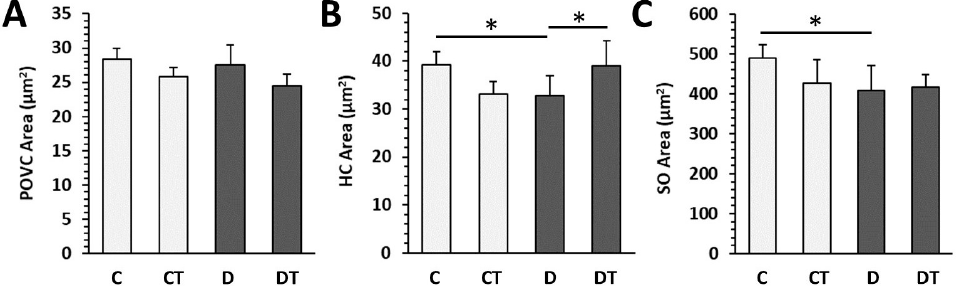
Figure 6. Histomorphometrical parameters in non-diabetic rats (C), those treated with cemtirestat (CT), STZ-induced diabetic rats (D), and those treated with cemtirestat (DT). ( A ) Primary osteons’ vascular canals (POVC) area, ( B ) Haversian canals (HC) area, and ( C ) secondary osteons (SO) area. The values are represented as mean ± SD. Only differences between groups C and D, as well as C and CT, and D and DT are indicated (* p < 0.05).